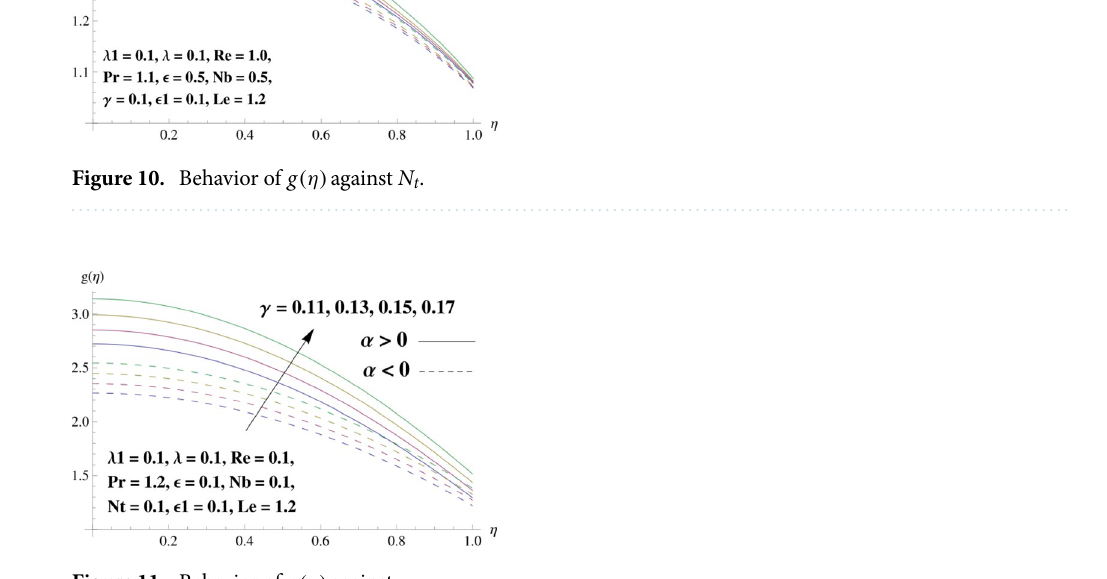
Figure 11. Behavior of g (η) against γ .